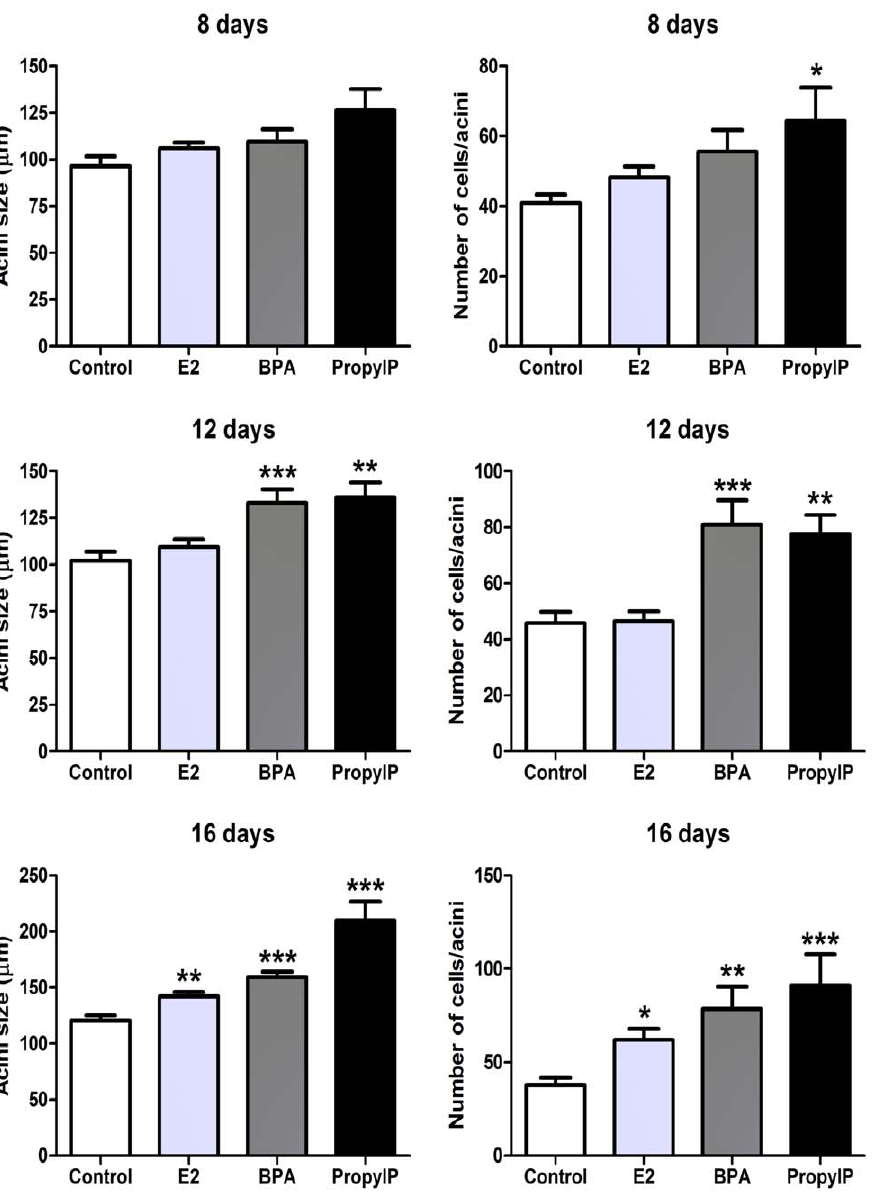
Figure 5. Quantification of acini size and cell number/acini. The size of acini ( m m) and the number of cells per acini were determined by analyzing confocal images of the incubation periods of 8, 12 and 16 days. Data corresponds to mean 6 SEM and results from three independent experiments, where a minimum of 10 representative acini were analysed per experiment. * (p , 0.05), ** (p , 0.01) and *** (p , 0.001) indicate significant differences between treatments and